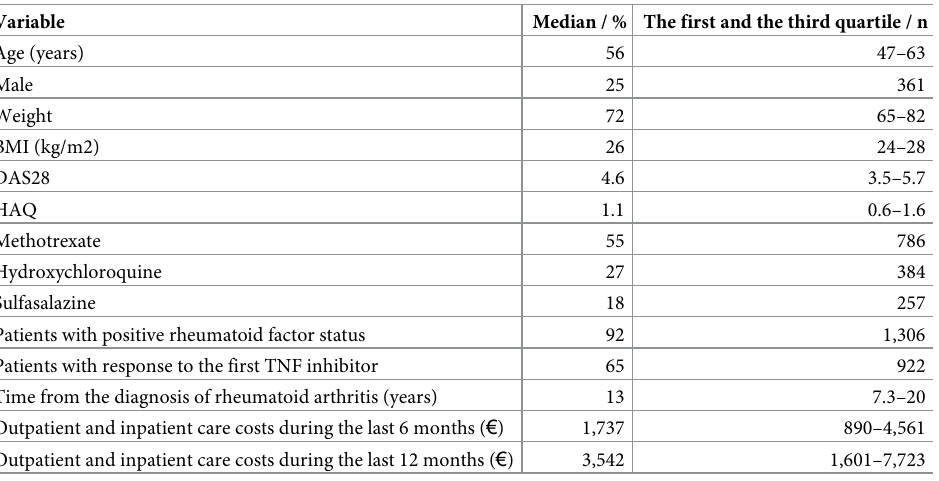
Table 1. Characteristics of the patients at the